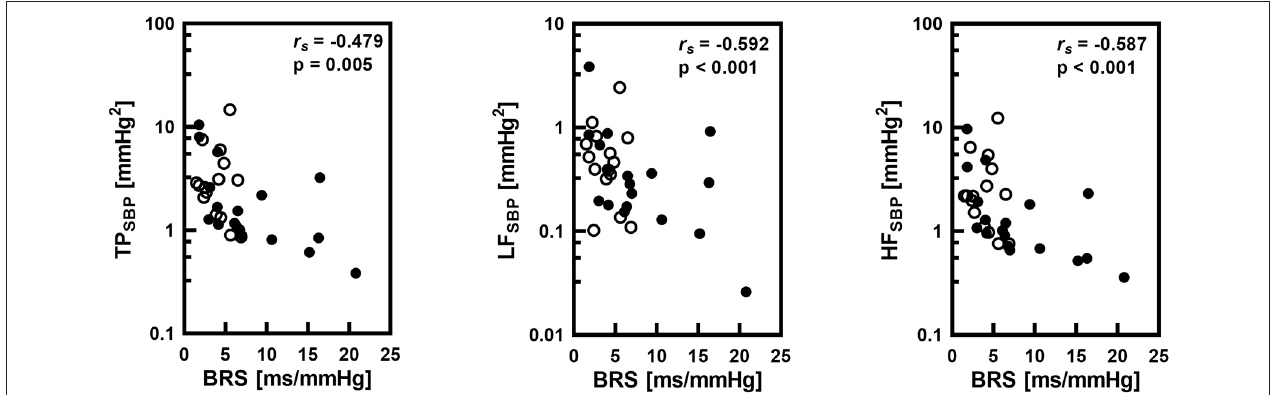
FIGURE 3 | Correlations between baroreflex sensitivity (BRS) and total power (TP), low frequency band spectral power (LF) and high frequency band spectral power (HF) of systolic pressure (SBP) variability with the Spearman’s correlation coefficient (r s ) and statistical significance level (p). Logarithmic scale was applied on y-axis. Empty circles corresponds to infants with gestational age below 32